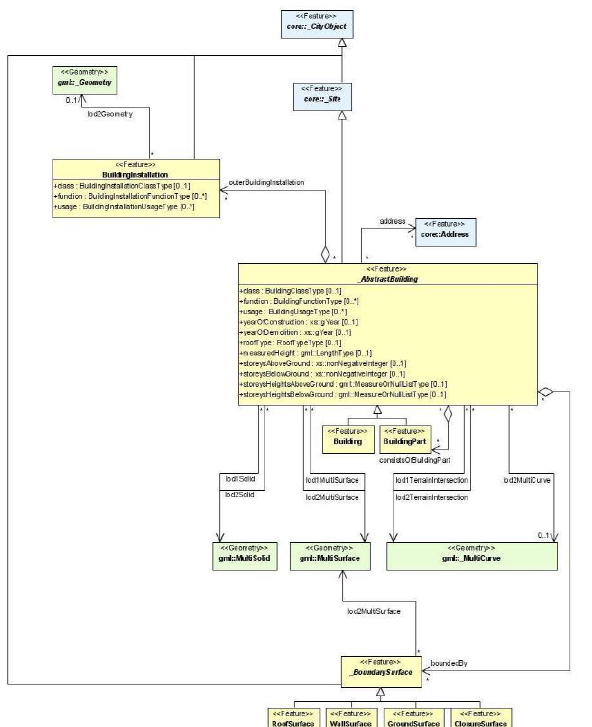
Figure 3.2: Overview UML diagram of City GML’s Building